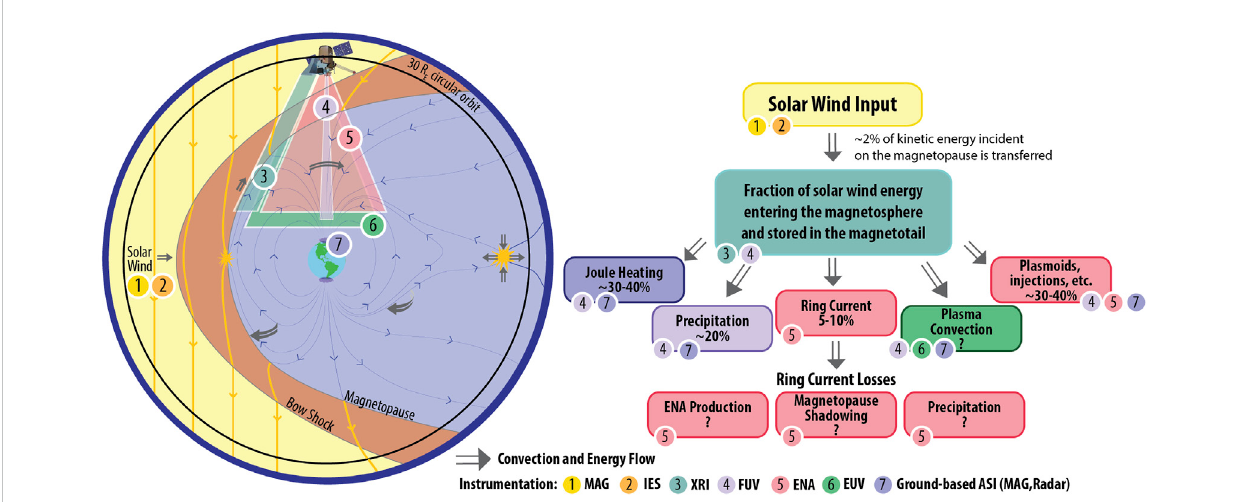
FIGURE 1 Left, an illustration of the fl ow of energy and magnetic fl ux in the Dungey cycle. Imposed on the left are the fi elds-of-view for imagers on a single spacecraftina30R E circularorbitwith90 ° inclinationtotheecliptic,capableofgloballyimagingthesolarwind-magnetosphereinteractionandtheentire Dungey cycle. The numbers identify speci fi c instruments corresponding to the fi elds-of-view in the left panel as well as in-situ and ground-based instruments which work with the imagers to investigate the Dungey cycle (legend bottom). The right side shows a hypothetical division of energy throughout the magnetosphere and relates this global magnetospheric energy budget to each instrument (number) and plasma regime. The energy budgets (percentages) shown on the right are estimated from previous studies (e.g., Baker and Pulkkinen, 1997; Knipp et al., 1998; Koskinen, 2002; Østgaard, 2002; Sandhu et al.,